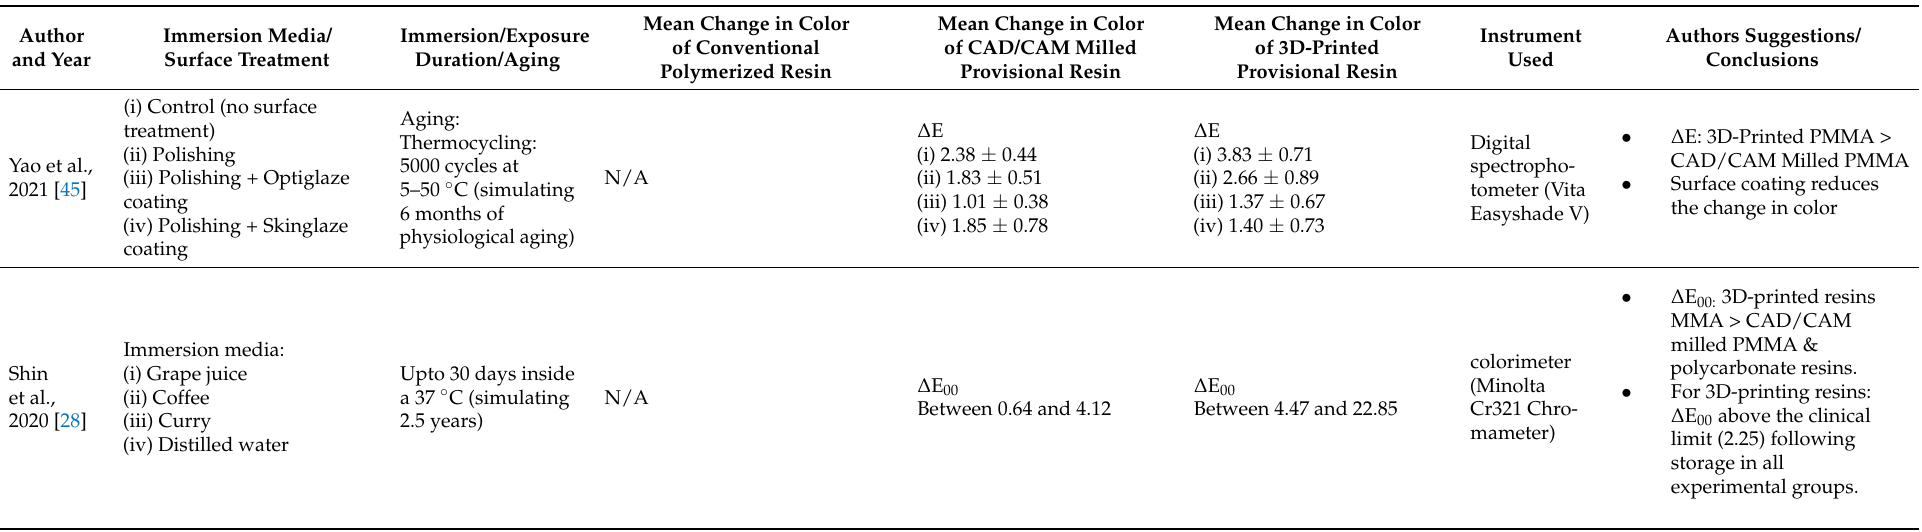
Table 5. Color change ( ∆ E/ ∆ E 00 )